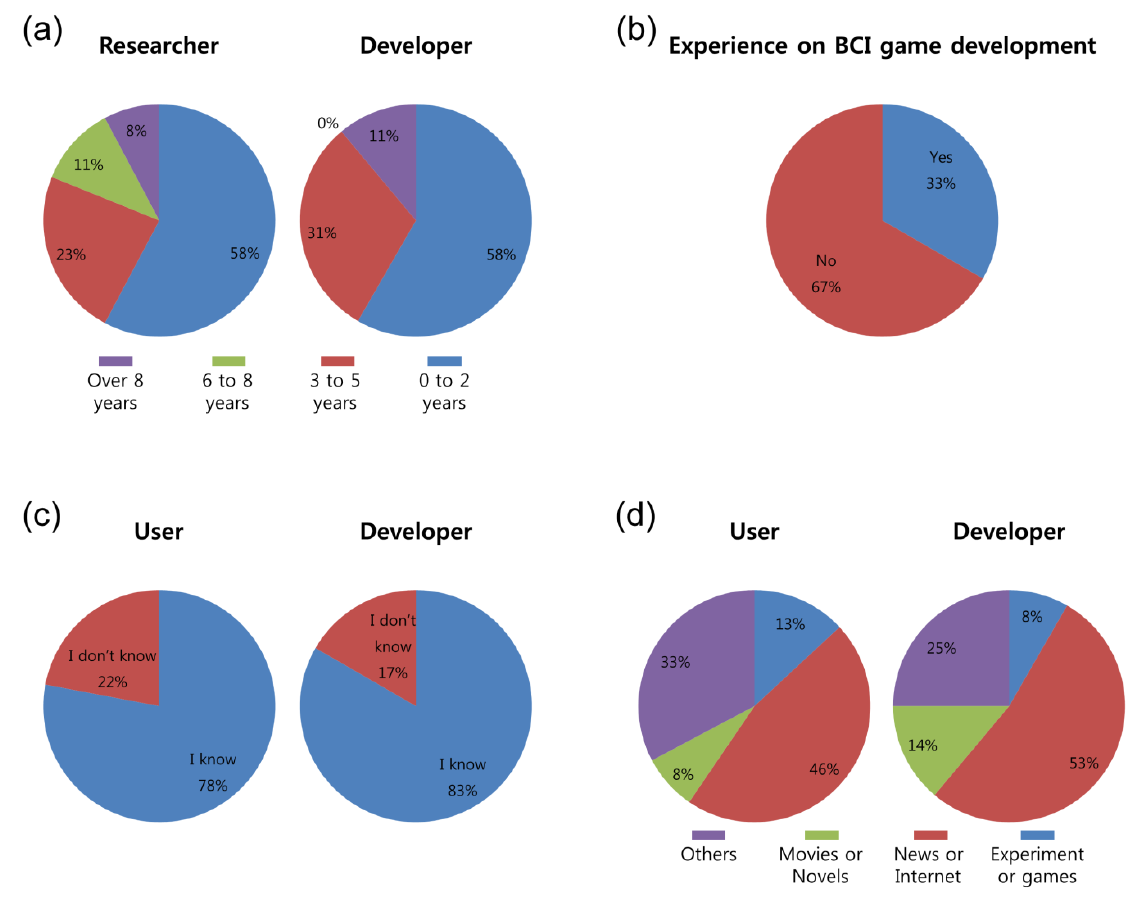
Figure 5. BCI and BCI game background. Responses to the questions: ( a ) years in research or development; ( b ) experience with the development of BCI games for researcher-only question; ( c ) whether the respondent knew of BCI or not; ( d ) how they knew about BCI. The percentages were calculated as percentages of users (N = 168), developers (N = 36) and researchers (N =